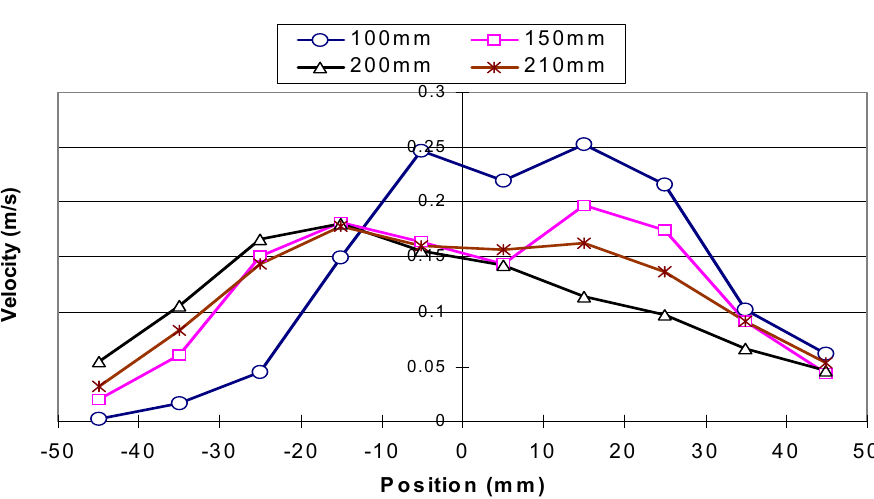
Fig. 11 : X-direction velocity for 90-degree and without fire-tube